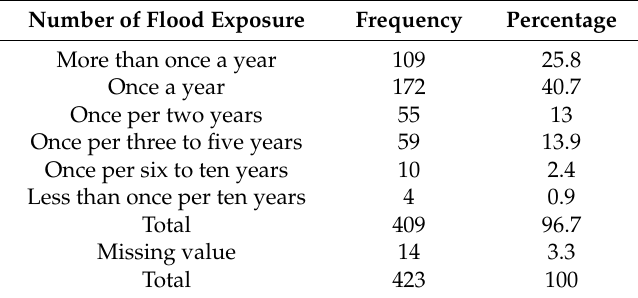
Table 4. Frequency of respondents’ exposure to urban floods.